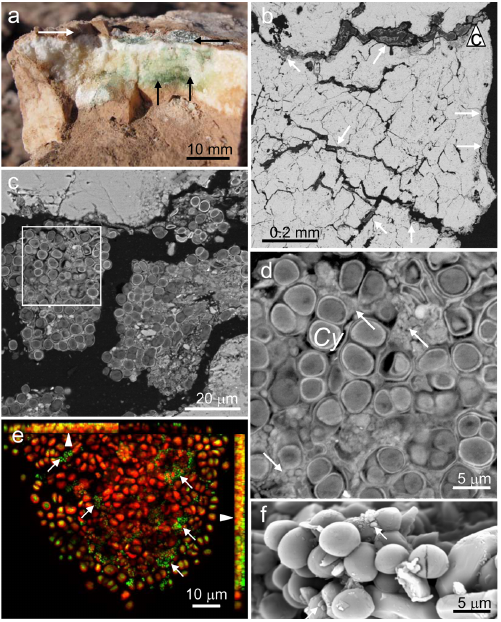
Fig. 2. Cross-sections of Luna calcite rocks and their microbial colonisation. (a) In field macroscopic view of calcite fissure wall revealing green spots of chasmoendolithic microorganisms (black arrows) beneath the rock surface. Note the presence of a hardened surface layer (white arrow) with microrills. (b) SEM-BSE low mag- nification image of transversal section showing the fissure and crack network within calcite rock; white arrows shows places where ag- gregates of chasmoendolithic microorganism cells where detected and the arrowhead indicates the position of the cells showed in (c) and (d) . (c) SEM-BSE image of cyanobacteria cell aggregates within a thick fissure. (d) Detailed SEM-BSE image from square area in (c) of cyanobacteria cells ( Cy ) associated with heterotrophic bacteria cells (arrows). (e) In situ fluorescence microscopy image (3-D reconstruction) of SYBR Green I stained chasmoendolithic microorganisms within the calcite rock obtained by SIM technique showing an undisturbed aggregate of cyanobacteria (red autofluo- rescence) and associated heterotrophic bacteria (green SBI signal); arrowheads point to lateral projections of the image. (f) SEM-SE image of external morphology of cyanobacteria cells with associ- ated heterotrophic bacteria